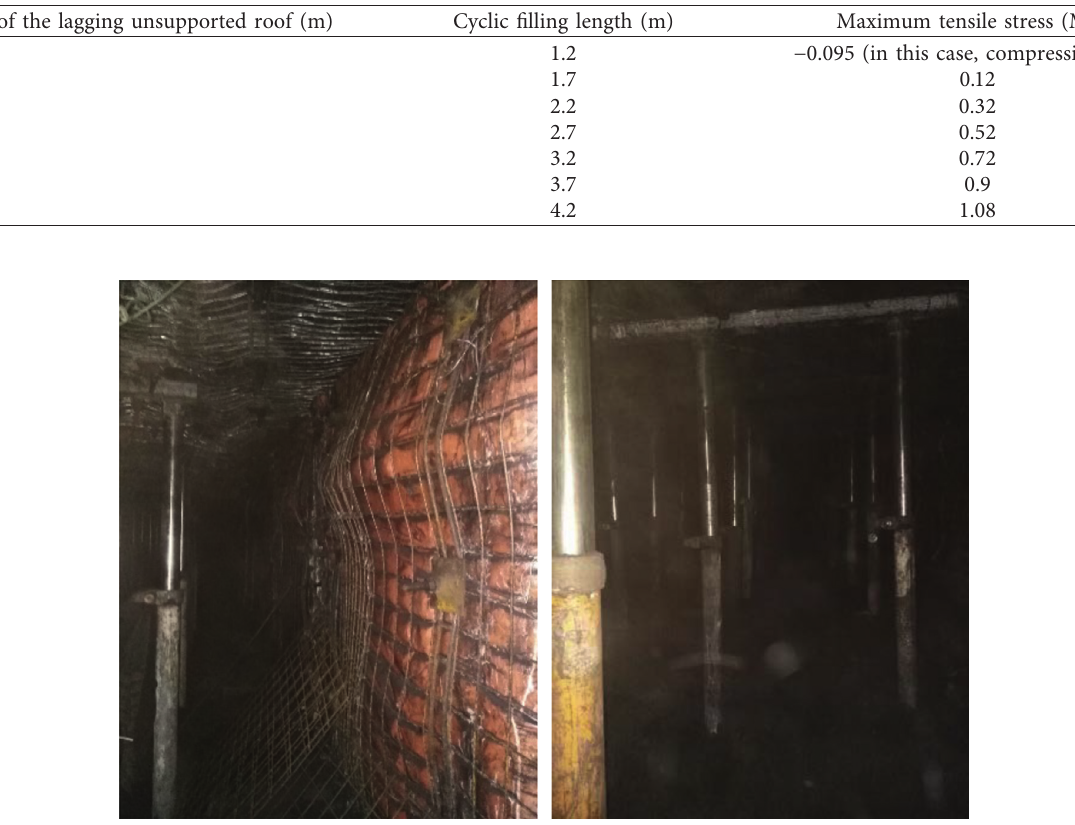
Figure 8: GER implementation effect of the #1103 working face in Heilong Coal